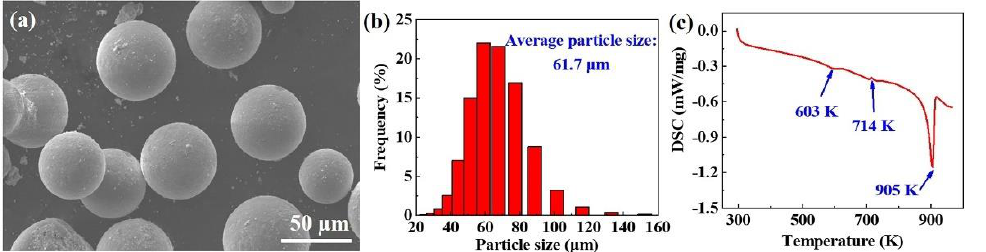
Figure 2. ( a ) SEM image of ZK61 powder and corresponding ( b ) particle size distribution with an average size of 61.7 μm ; and ( c ) DSC curve of the ZK61 sample.